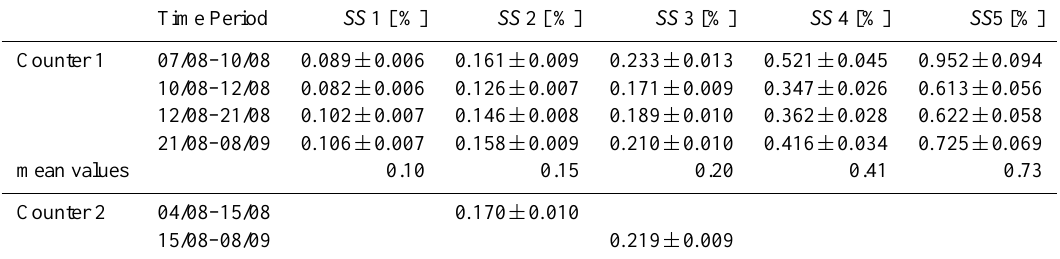
Table 1. The different measured supersaturations throughout the study. For simplicity, the mean values from counter 1 are used in the manuscript. All closure calculations were done using the respective mean supersaturation for each point in